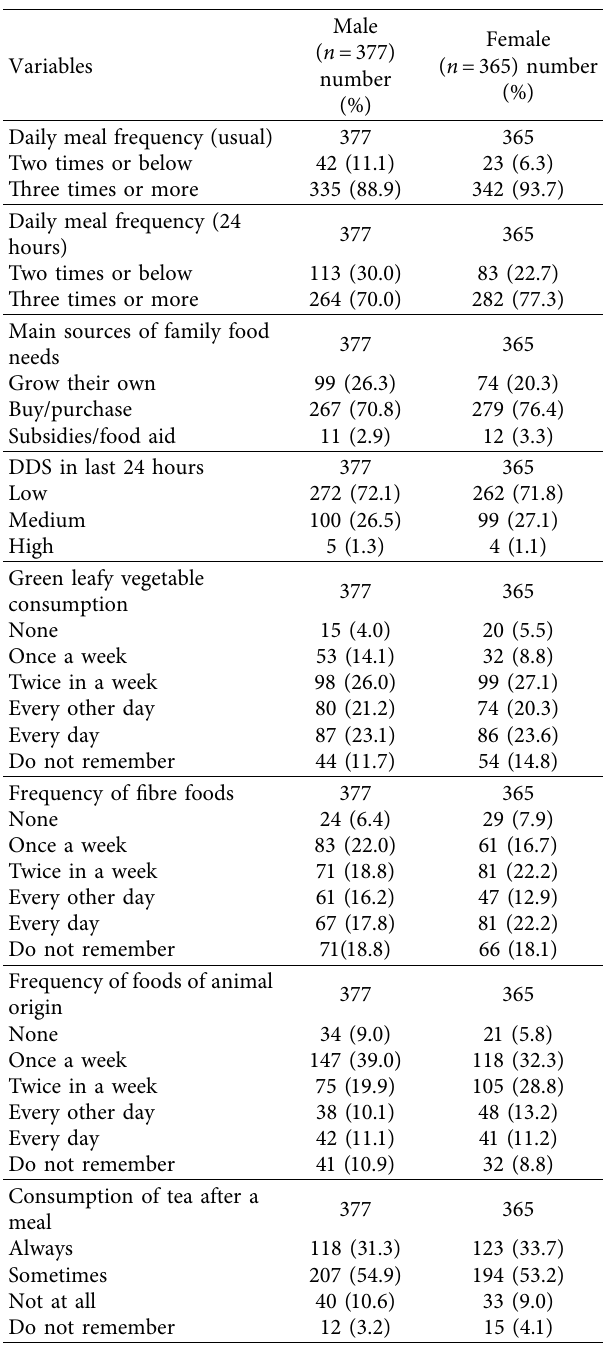
Table 2: Dietary practices and related factors among male and female adolescent students in Dilla Town, Gedeo Zone, Southern Ethiopia, May